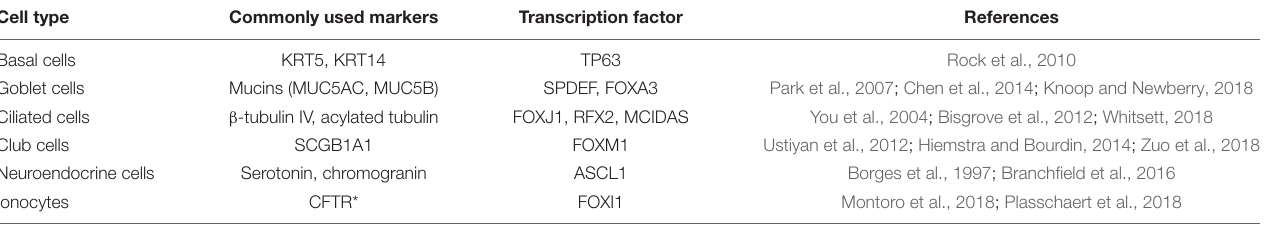
TABLE 1 | Main cell types composing the AE and associated protein and transcription factors (non-exhaustive list) reported to be specific of each cell type within the AE.